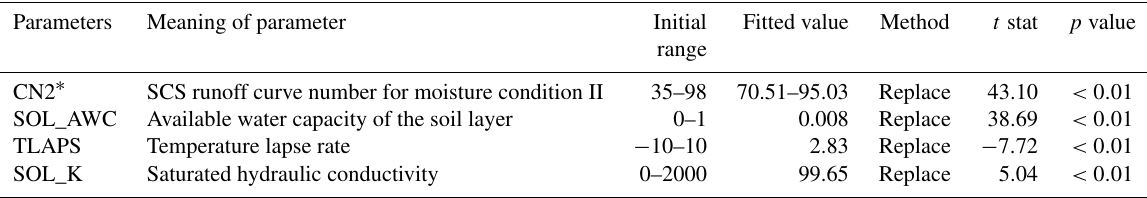
Table 1. Sensitivity analysis and final value range of parameters in Jinta River basin.